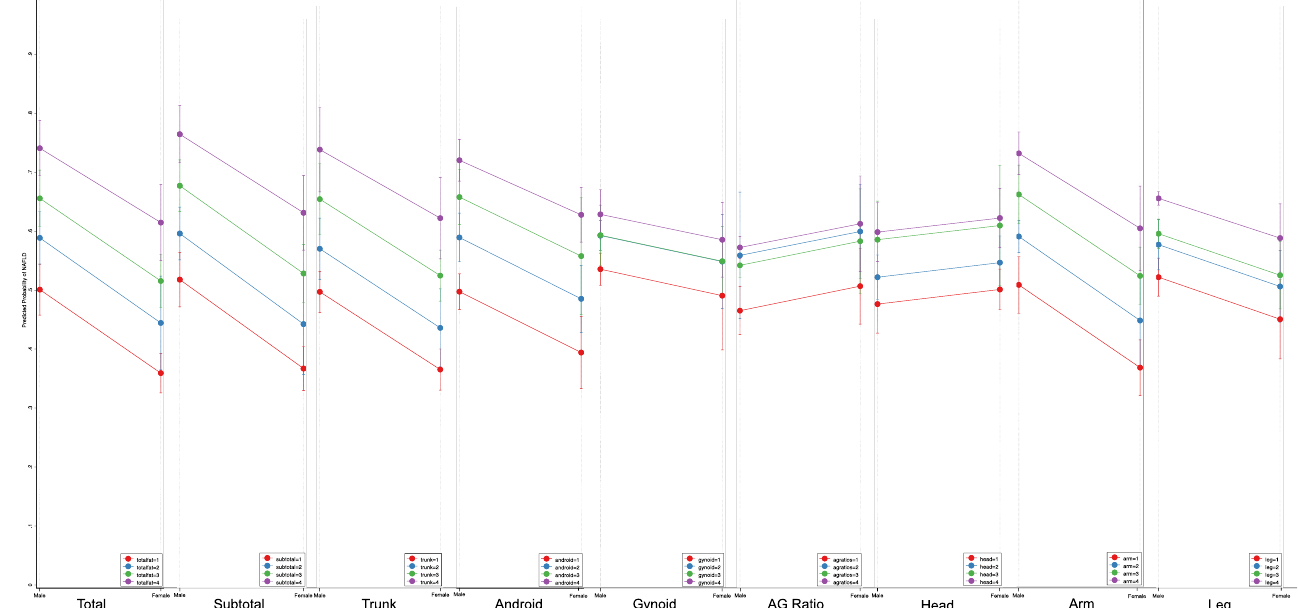
Figure 3. Predictive Probability of Regional Body Fat Percentages and Risk of NAFLD Development in Obese Population.